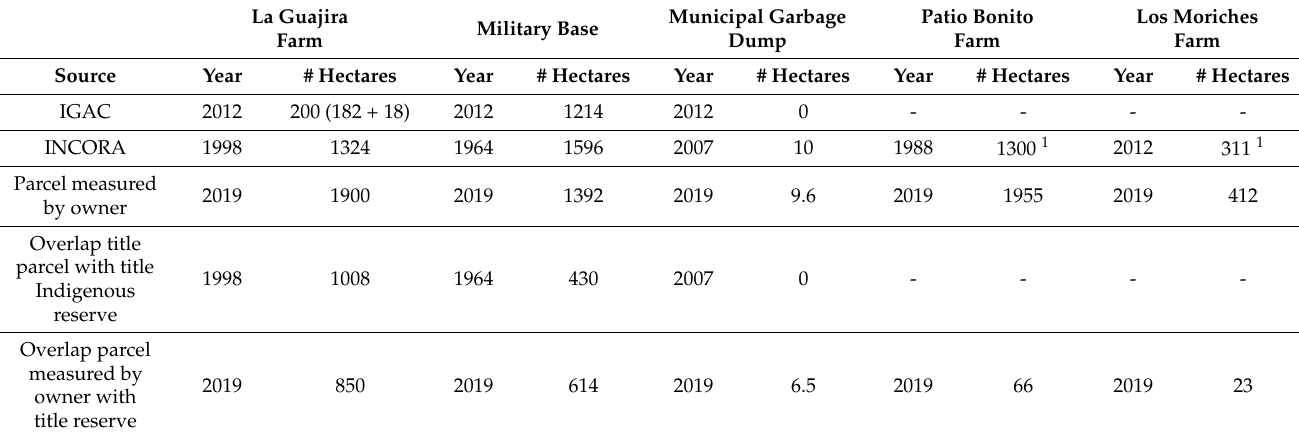
Figure 6. Sold lots on the land that overlaps with the Indigenous Santa Teresita del Tuparro reserve. The lots overlap with the network of roads that is officially the limit of the reserve. Cumaribo, 2019. Source: Land in Peace Project, Kadaster. Table 1 shows the areas of each parcel according to the cadastral institutions in Colombia compared to the areas that resulted from the field measurements of 2019. It also shows the area of the overlaps between the corresponding parcel and the Indigenous reserve. What can be seen is a significant difference in the areas known by the different governmental land institutions, such as IGAC and, for example, INCORA, the former National Land Agency. Furthermore, there are many differences between the areas in the official State registries and the areas indicated by the land users themselves in the field. For example, according to the documents of the parcel La Guajira, the parcel measures 1324 ha. However, the FFP field measurements show that the parcel has an area of 1900 ha. Table 1. The size of the measured parcels in hectares and the number of hectares overlapping with the Indigenous Santa Teresita del Tuparro reserve.